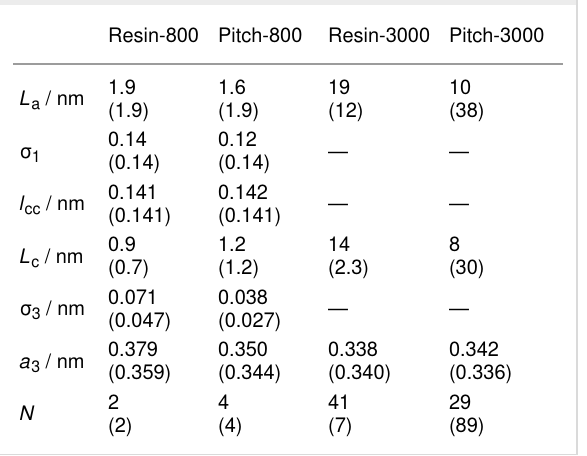
Table 2: WAXS parameter for the pitch- and resin-based carbon mate- rials. The parameter based on the corresponding non-templated bulk materials are shown in brackets.